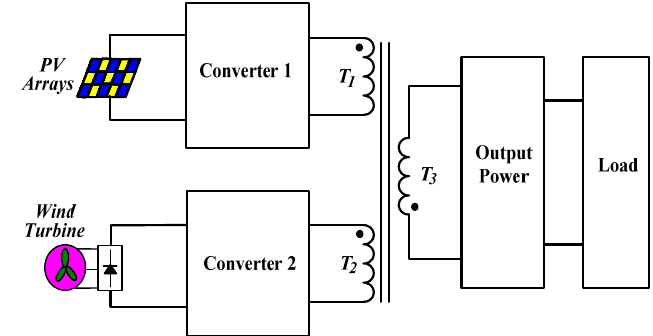
Figure 2. Two separated DC/DC converters for PV arrays and wind turbine